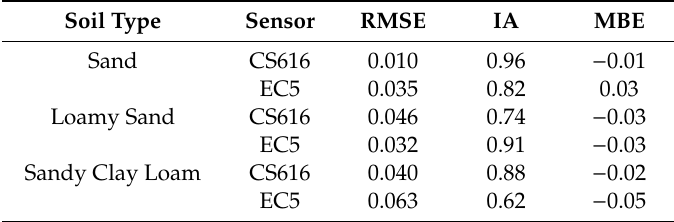
Table 3. Statistical analysis to compare measured value to sensor